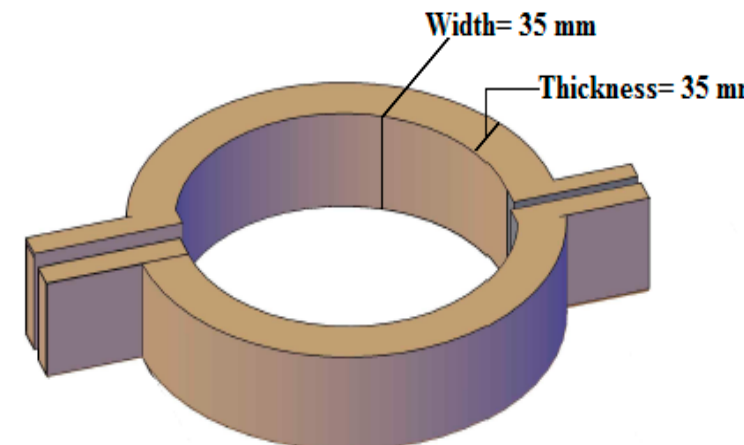
Figure 1. The circular rings of the experimental